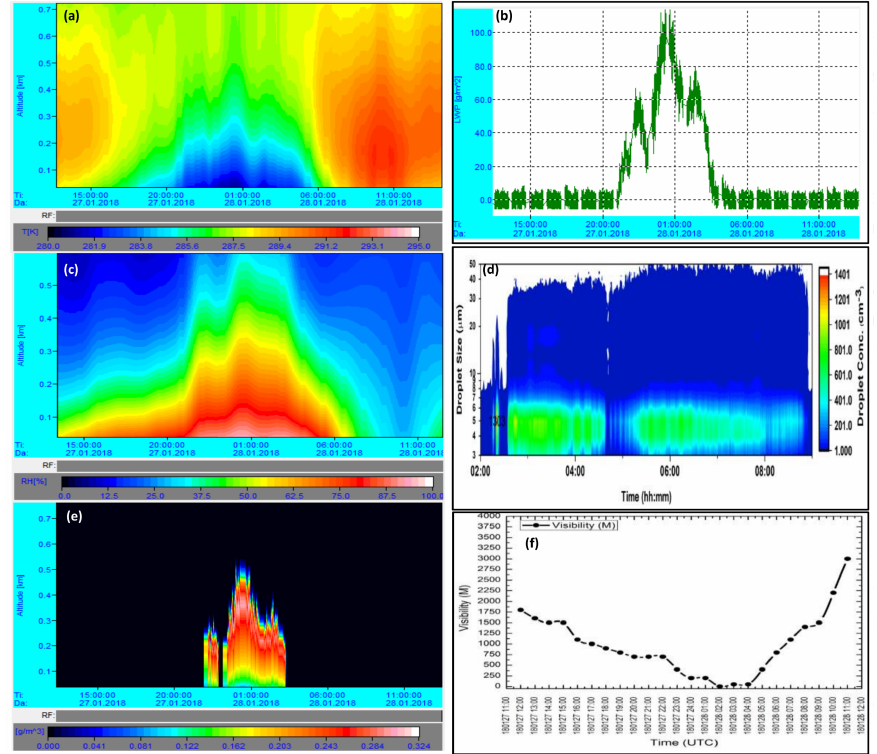
Figure 4. The time and height cross-section of ( a ) temperature profiles observed from the microwave radiometer (MWR), ( b ) liquid water path (g / m 2 ) observed from the microwave radiometer (MWR), ( c ) humidity profiles observed from the microwave radiometer (MWR), ( d ) temporal evolution of the fog number droplet concentration as a function of droplet diameter during the dense fog event of 28 January 2018 (2–10 UTC), and ( e ) liquid water profiles from the surface to 700 m and observed from the microwave radiometer (MWR), and ( f ) hourly visibility from 27 January 2018 (12 UTC) to 28 January 2018 (12 UTC) at IGI Airport Delhi. MWR profiles are shown at IGI Airport, New Delhi from 27 January 2018 (12 UTC) to 28 January 2018 (12